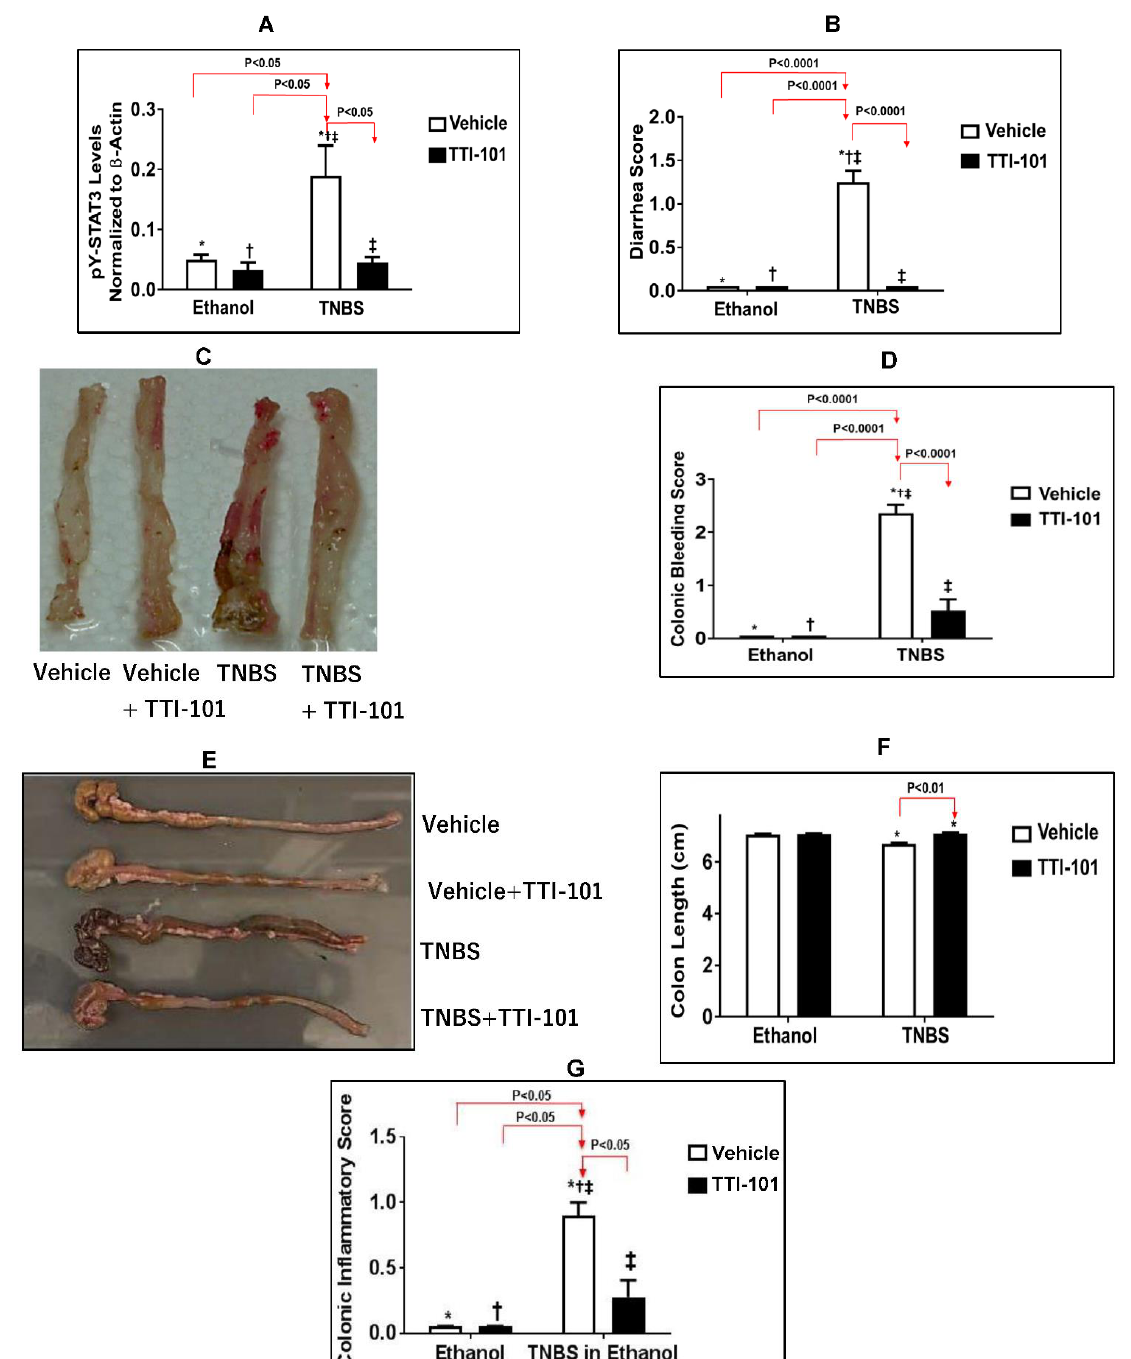
Figure 3. Effect of TTI-101 treatment on colon levels of pY-STAT3 protein, diarrhea, colonic bleeding, colon length, and colon inflammation in TNBS-induced CD. ( A ) pY-STAT3 levels were measured by Luminex assay in the colons of mice that received 50% ethanol or TNBS in 50% ethanol and treated with vehicle (DMSO) or TTI-101 in DMSO. pY-STAT3 levels were normalized to β -tubulin protein levels and the means ± SD of the ratios plotted. ( B ) Diarrheal score, ( C , D ) colonic bleeding, ( E , F ), colonic inflammation, and ( G ) colon length were assessed 48 hrs. post-administration of TNBS. Results are expressed as the mean ± SEM of two separate experiments (( A , B , D , G ): *, Ethanol vs. TNBS, † , Ethanol+TTI-101 vs. TNBS, and ‡ , TNBS vs. TNBS+TTI-101, all p < 0.05; ANOVA followed by Tukey’s post -test; n = 3 – 12), ( F ): *, TNBS vs. TNBS+TTI-101. p < 0.05; ANOVA followed by Tukey’s post -test; n = 6 – 12).